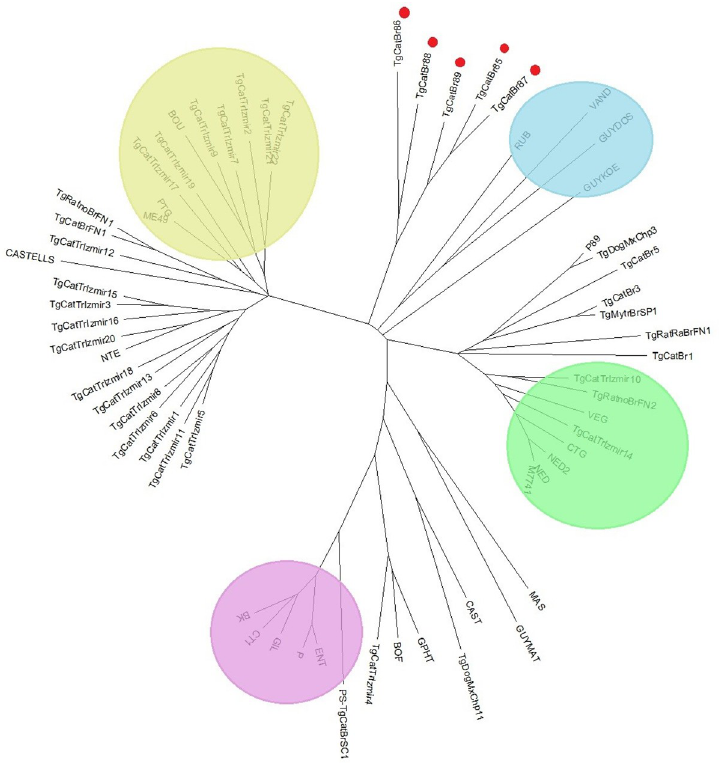
Fig 2. Neighboring cluster of Toxoplasma gondii strains based on 15 microsatellite markers. The lilac color indicates the type I (ENT), beige type II (ME49) and green type III (NED), which are the reference strains; The blue color indicates atypical strains found in French Guiana. The red dots indicate strains from the present study.